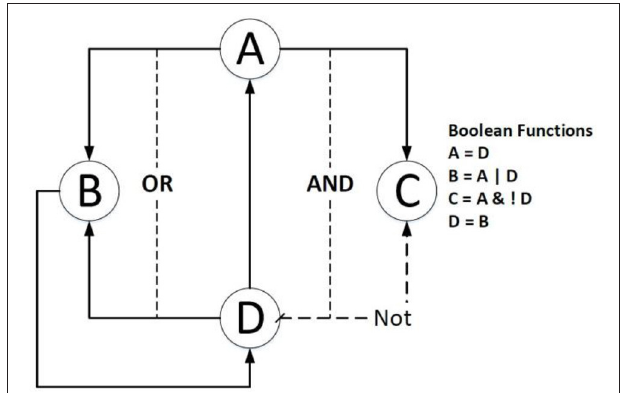
FIGURE 1 | An example of a simple Boolean Network. The right side lists the Boolean functions of the example; the dashed line means the source gene is expected to be inhibited; the solid line indicates that the source gene is expected to be